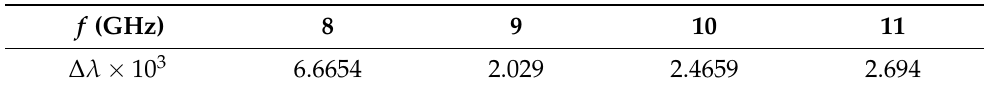
Table 4. The difference between the first dominant eigenvalue and those belonging to the null space at four different frequencies.